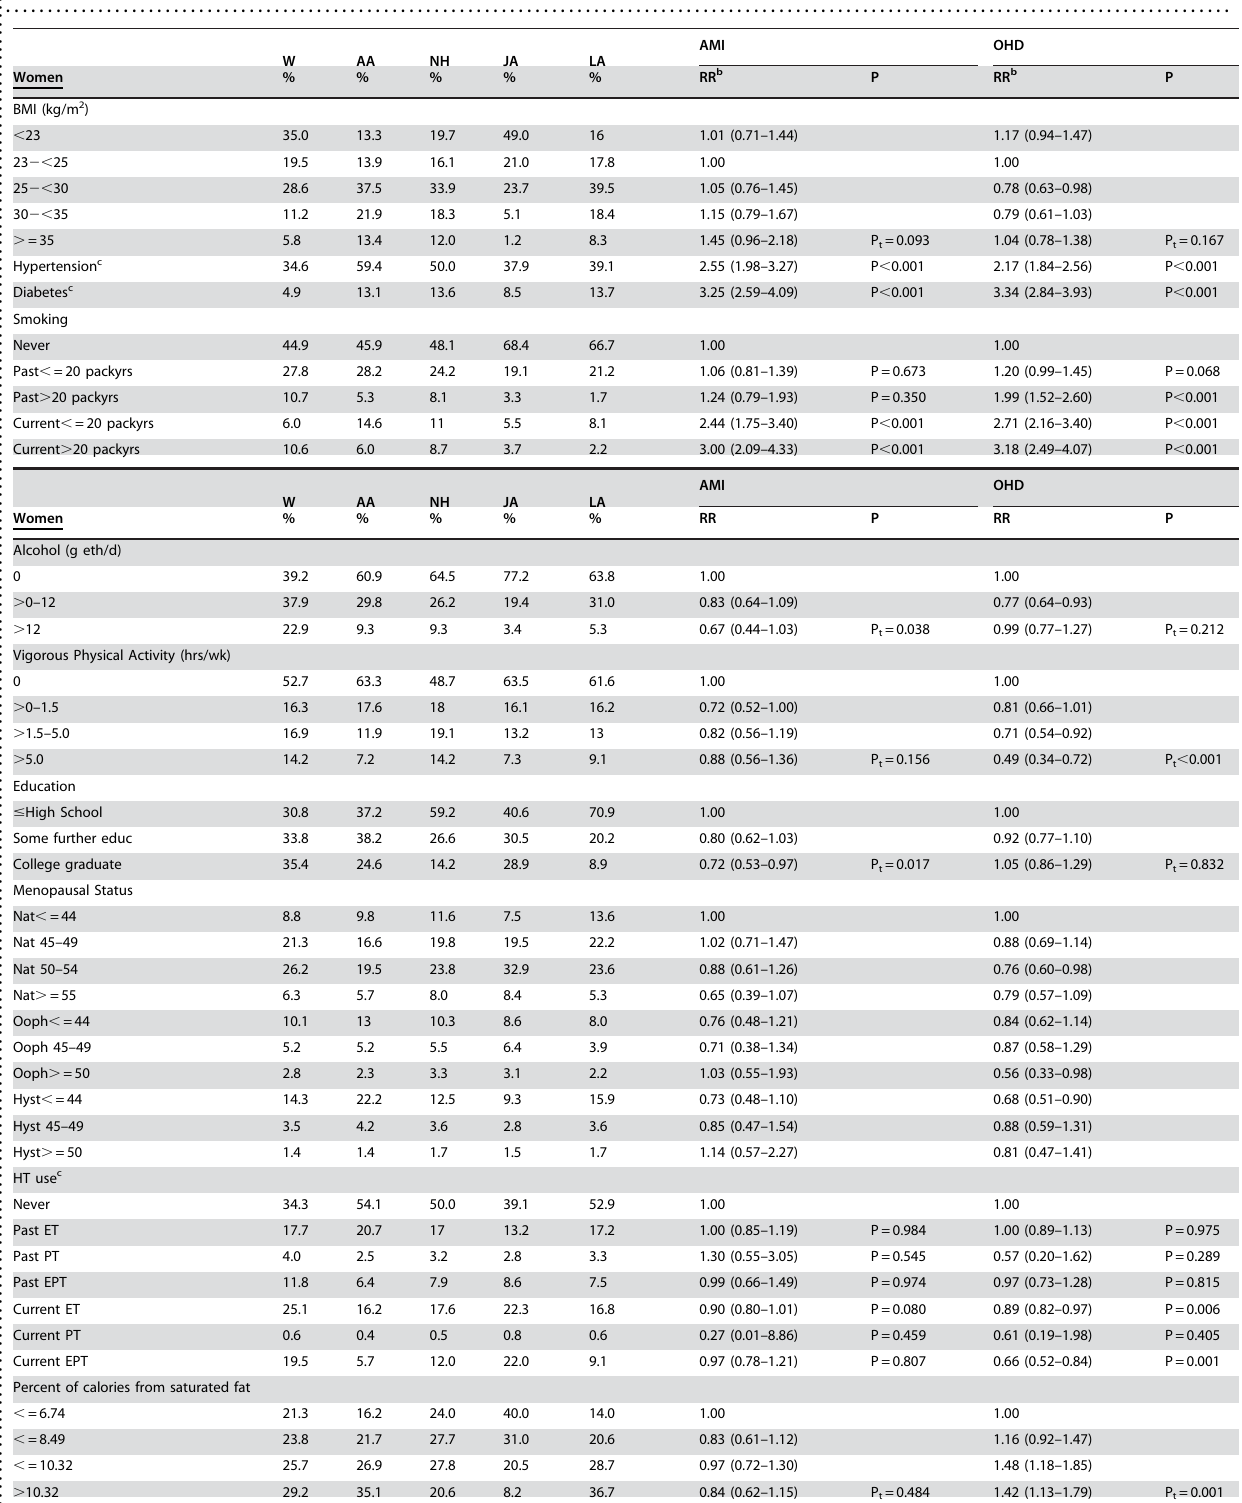
Table 3. Age-standardized a distributions of risk factors with associated RRs of mortality from AMI and OHD among women in the